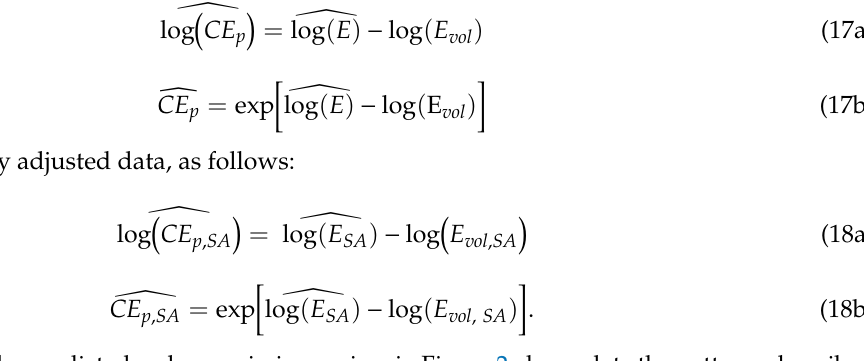
Table 6. Correlation between log(E)(cid:3555) and log(E) (cid:2903)(cid:2885) (cid:3555) .